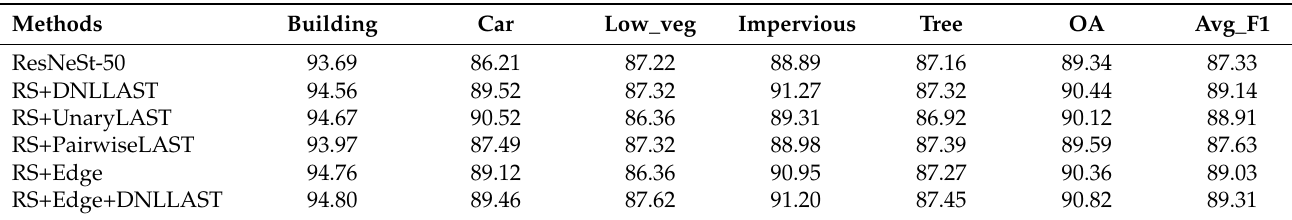
Table 3. Quantitative analysis (%) of the components in the proposed model based on the Potsdam dataset. The average F1 score was calculated using all classes expect the background. All results are based on an edge-erosion statistic. Methods